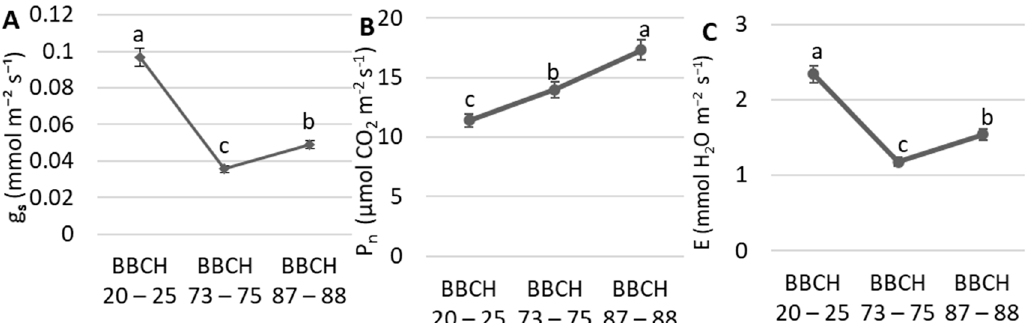
Figure 2. Effect of seasonality regardless distances between trees on the stomatal conductance g s ( A ), photosynthetic rate P n ( B ), and transpiration rate E ( C ). The different letters in graphics indicate significant differences. The data were processed using one-way analysis of variance (Anova), the Turkey (HSD) test at the confidence level p = 0.05.